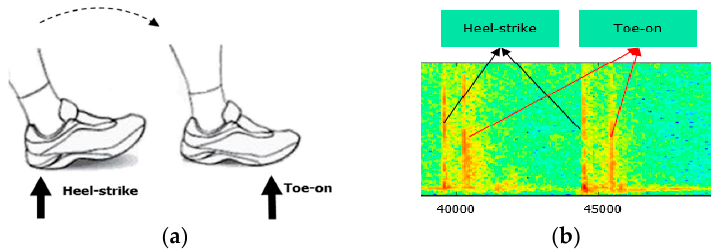
Figure 2. ( a ) Acoustic impacts of footstep events; ( b ) Acoustic impact signals of a footstep in a spectrogram.